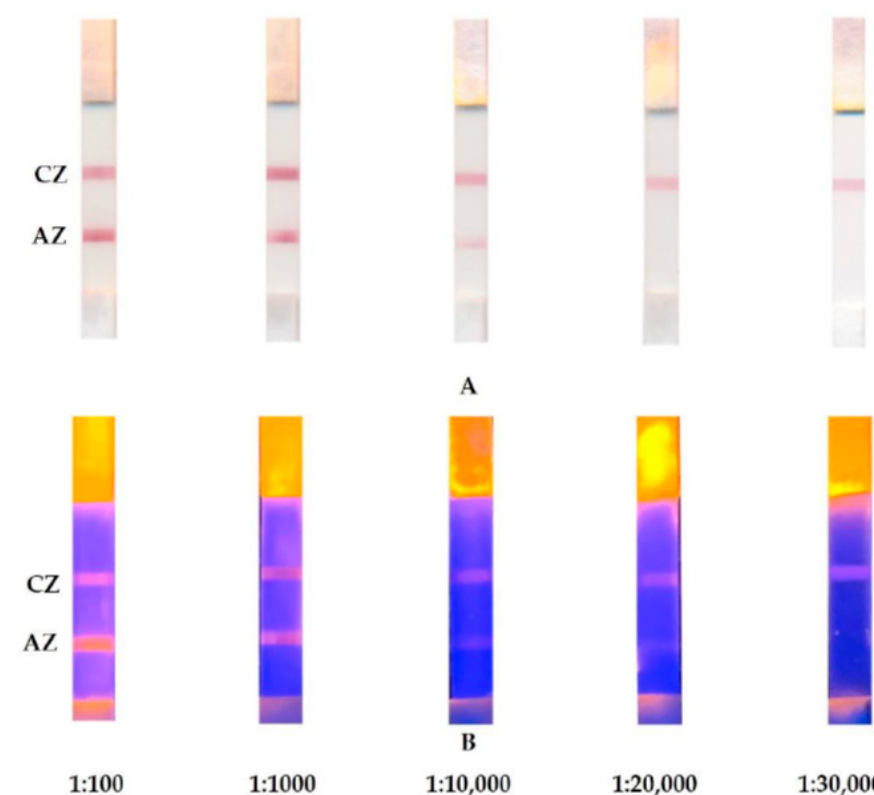
Figure 5. Testing of diluted standard serum sample by immunochromatographic systems for serodiagnostics of cattle brucellosis with GNPs ( A ) and GNPs + QDs ( B ). AZ—analytical zone; CZ—control zone.